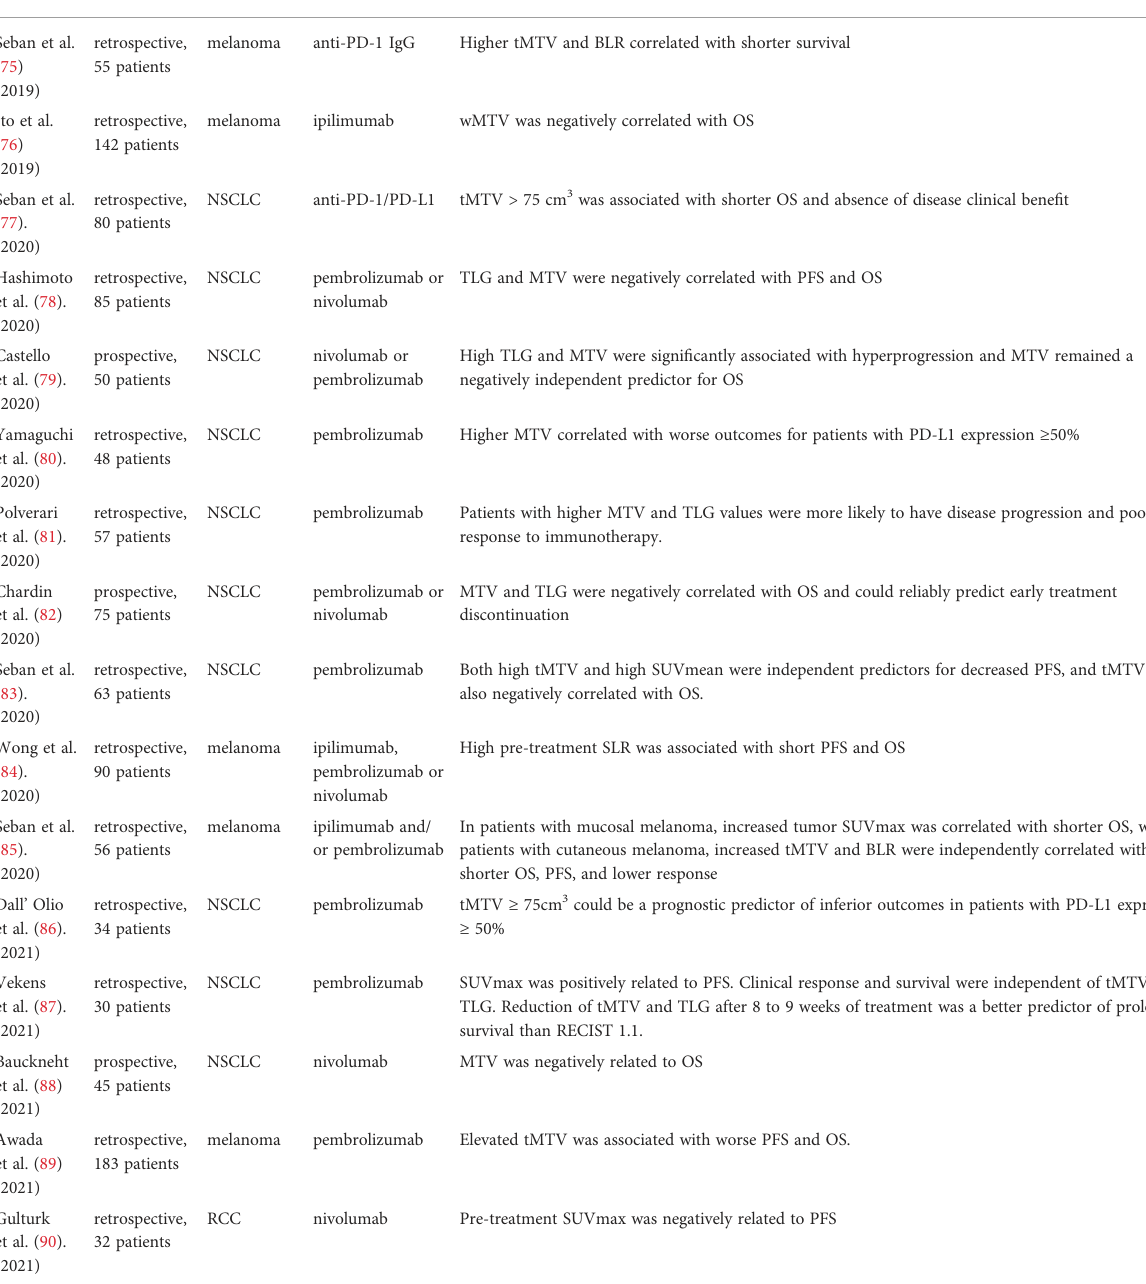
TABLE 4 Prognosis predictive role of 18 F-FDG PET/CT in